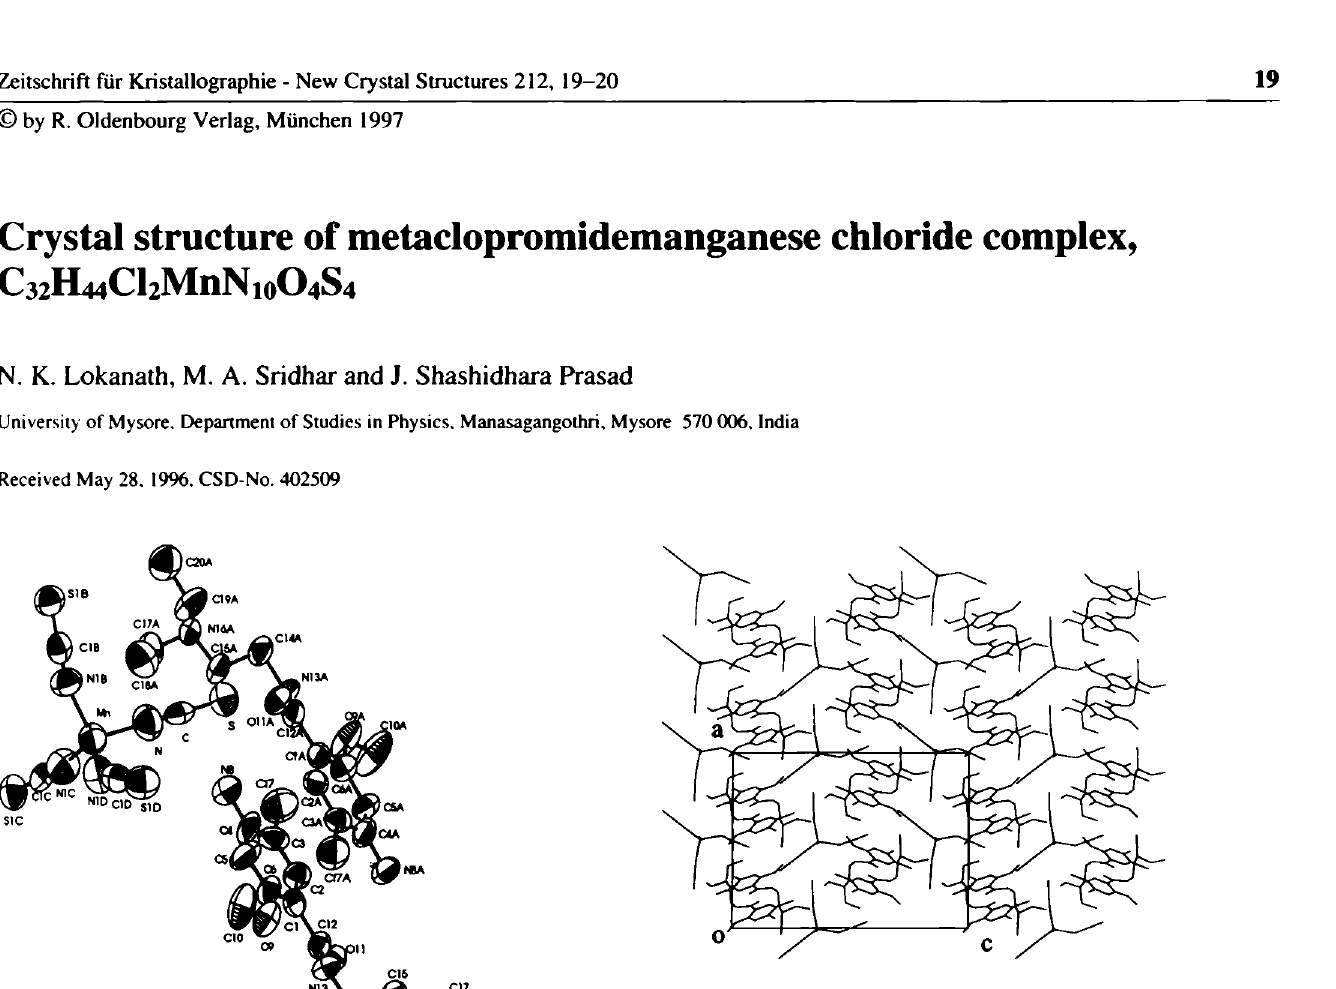
Fig. 2. Packing of molecules down b.